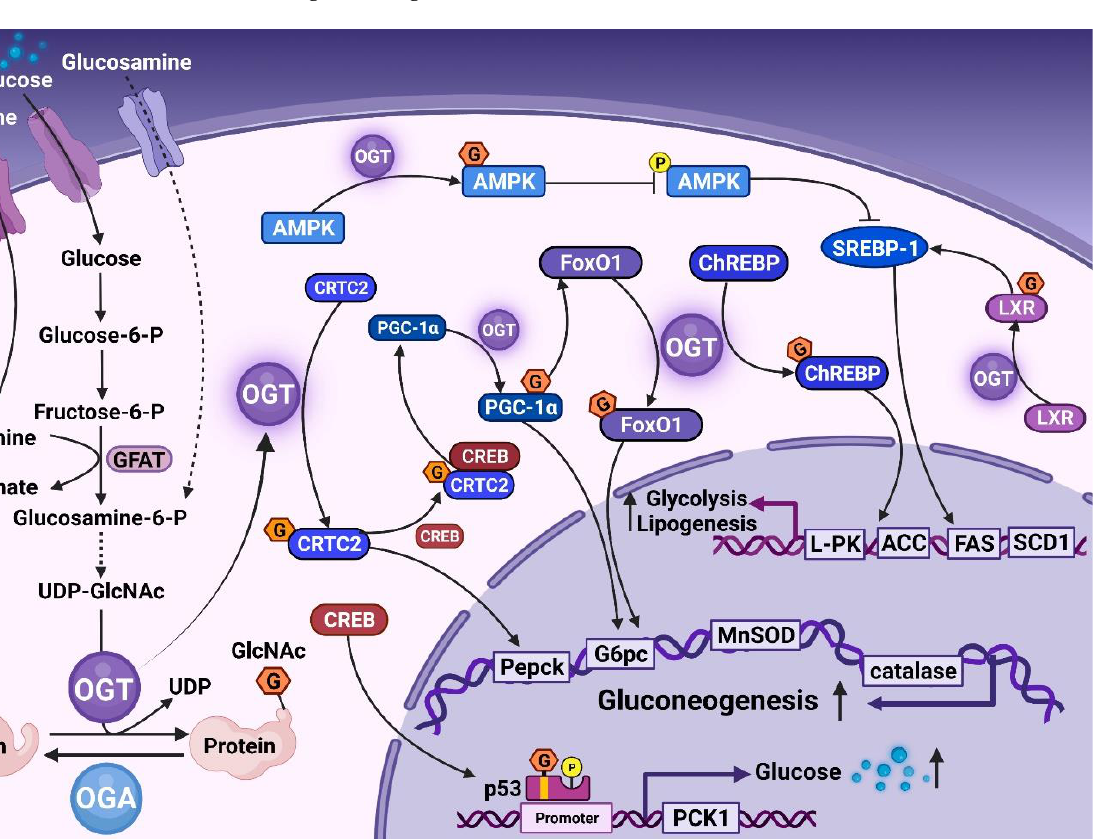
Figure 1. O-GlcNAcylation maintained normal physiological homeostasis in the liver. The HBP regulated the level of O-GlcNAcylation, and OGT catalyzed the transfer of single N-acetyl glucosamine from UDP-GlcNAC to the proteins; hydrolysis of a single N-acetylglucosamine from the proteins by OGA. O-GlcNAcylation of PGC-1 α , FoxO1, and CRTC2 increases the expression of gluconeogenic genes and induces hepatic gluconeogenesis. O-GlcNAcylated p53 bound to the PCK1 promoter regulated the PCK1 levels and increased glucose